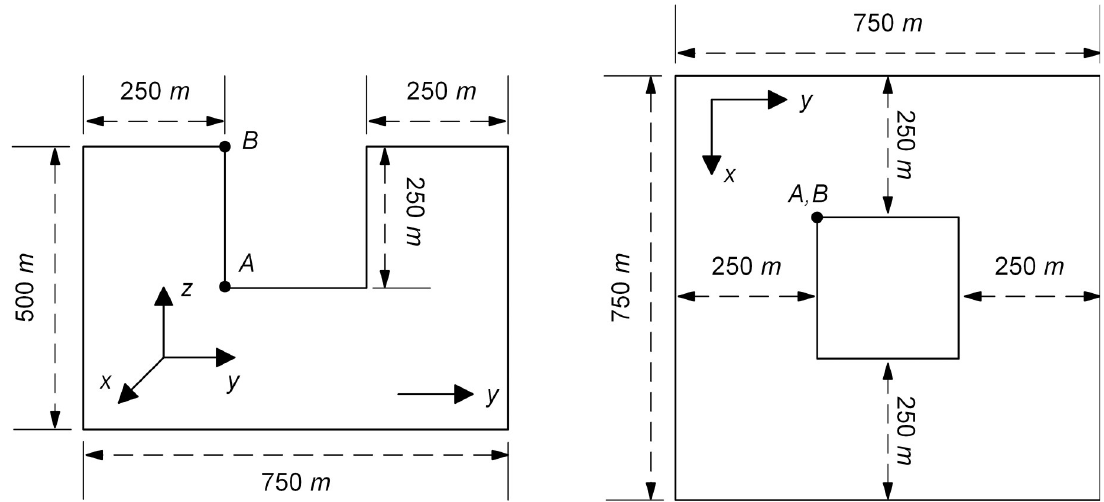
Fig 9. Computational domain in the scattering problem.